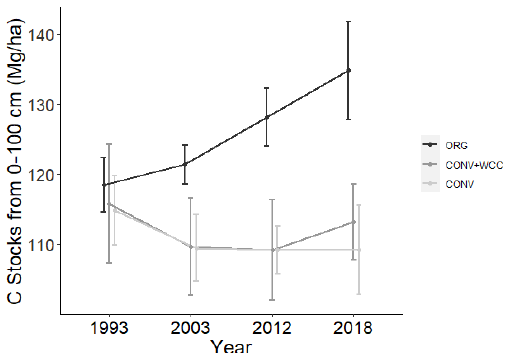
Figure 2. Carbon stocks of the 1m profiles of ORG, CONV + WCC, and CONV systems from 1993 to 2018. Carbon stocks are given in megagram per hectare. Error bars denote standard error. Please note that all systems transitioned from furrow to drip irriga- tion in